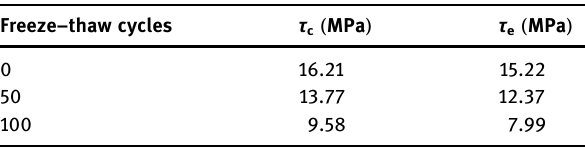
Table 3: The comparison of simulation results ( τ c ) and